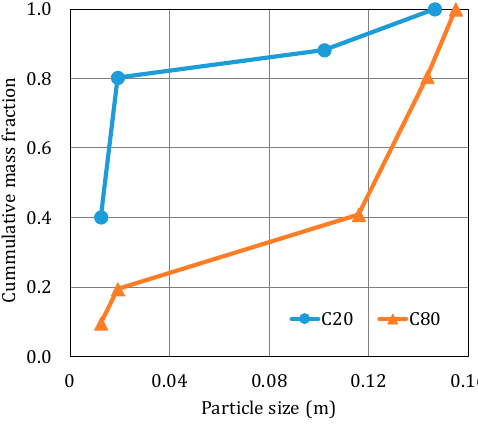
Figure 3. Particle size distribution of the composites used in the leaching experiments.